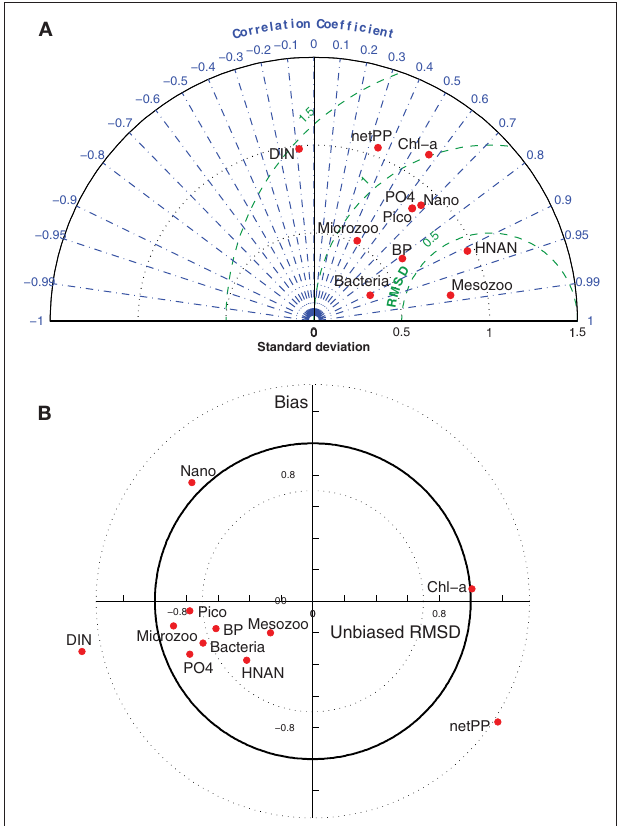
FIGURE 4 | (A) Taylor and (B) target diagrams indicating the correlation coefficient, standard deviation ( STD ), RMS error and the model bias (Bias), unbiased RMS error respectively, for model simulated PO 4 , DIN, Chl-a, net primary production (netPP), bacterial production (BP), and biomass of nanophytoplankton (Nano), picophytoplankton (Pico), bacteria, HNAN, microzooplankton (Microzoo), and mesozooplankton (Mesozoo) from all treatments against available observations. Both diagrams are normalized by the standard deviation of the observed data (e.g., STD 1 means that the = model has the same standard deviation with